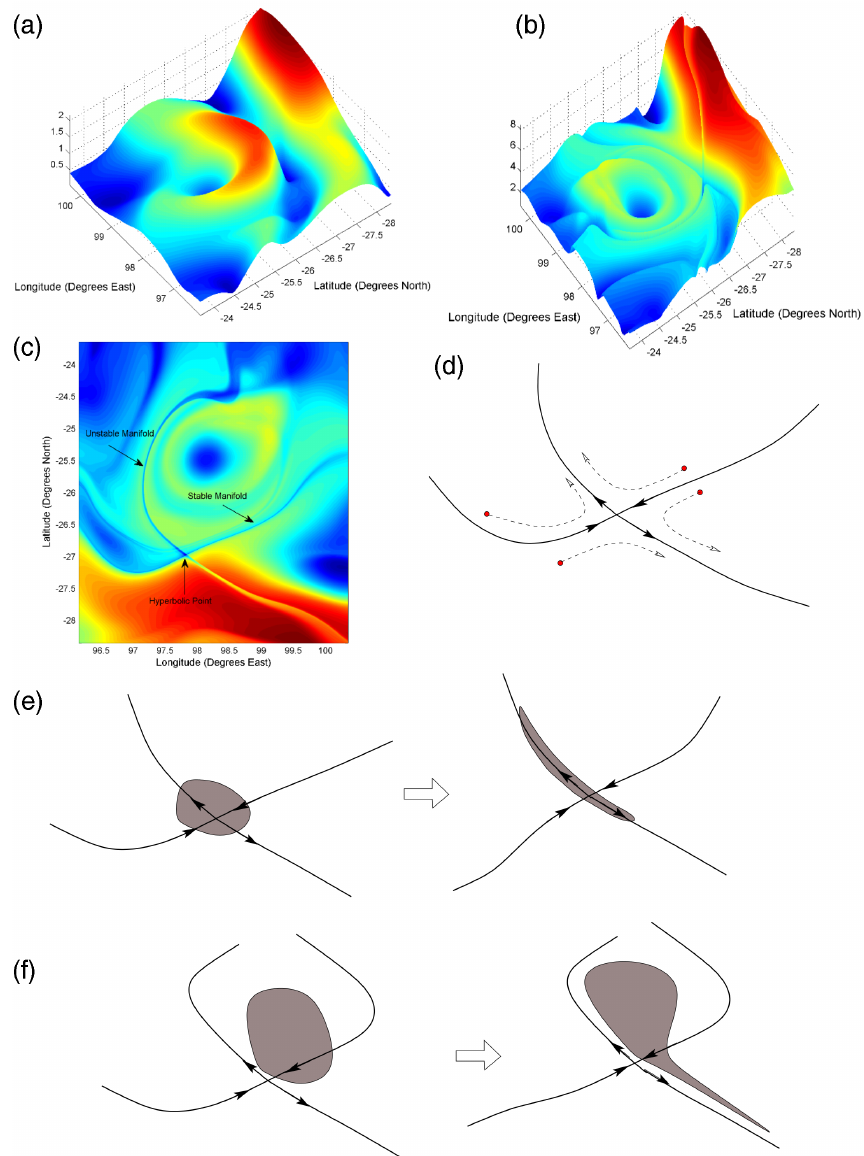
Figure 1. Evaluation of the M function for AVISO data in the southern Indian Ocean on the 8 March 2014: (a) τ = 5 days, (b) τ = 20 days, (c) a countour plot of (b) highlighting the position of visible invariant manifolds and a hyperbolic point, (d) a schematic representation of the manifolds of (c) showing the particle evolution in the neighborhood, (e) tracer blob evolution in a neighborhood of the crossing of the stable and unstable manifolds and (f) tracer blob evolution in a neighborhood of a hyperbolic point and a elliptic (eddy-like)